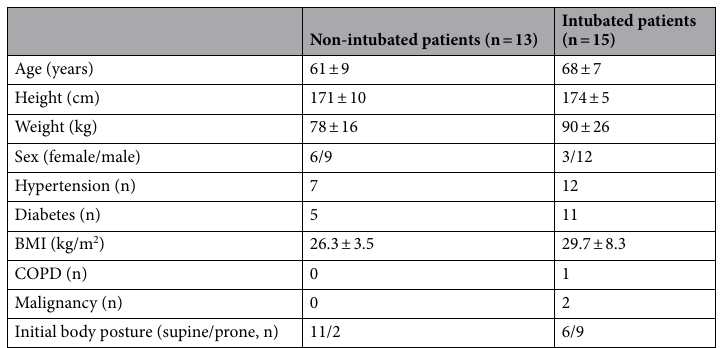
Table 1. Anthropometric and clinical data of the patients. Values are presented as mean ± standard deviation. BMI : Body mass index, COPD Chronic obstructive pulmonary